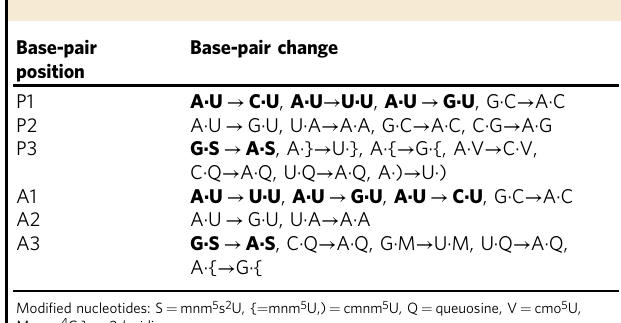
Table 1 Base-pair changes contributing to the codon – anticodon interactions in the mRNA sequences of the Tsuchihashi data set